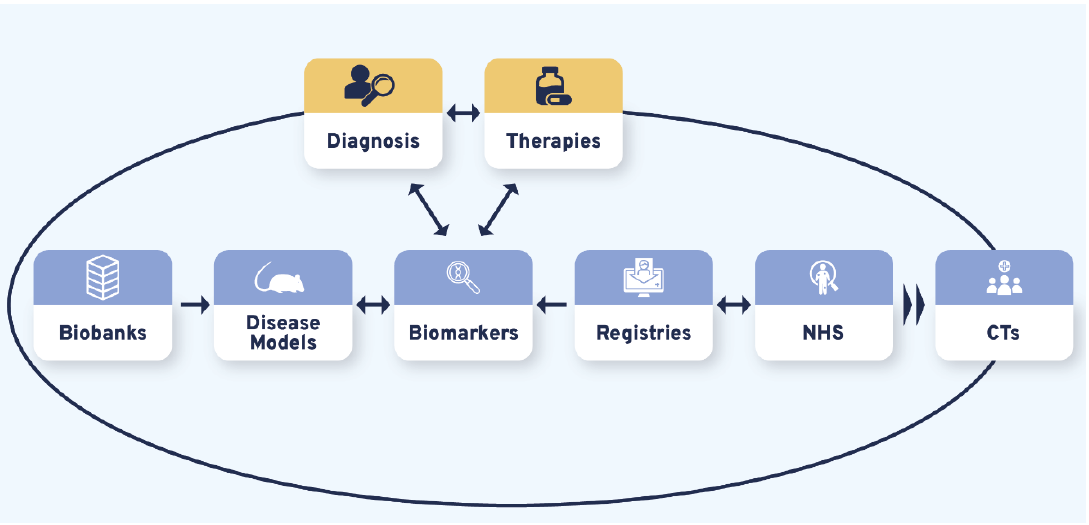
Figure 4. The CDG research tools interdependency. Variable and multiple interconnections were established between the CDG therapy R&D tools with all influencing CTs. Diagnosis and possible therapies were identified as essential triggers for the CDG therapy R&D flux, represented by the larger black circle. The smaller blue, orange, and yellow circles depict the uncovered reciprocal associations between different research tools. Legend: CTs—Clinical trials; NHS—Natural history studies.